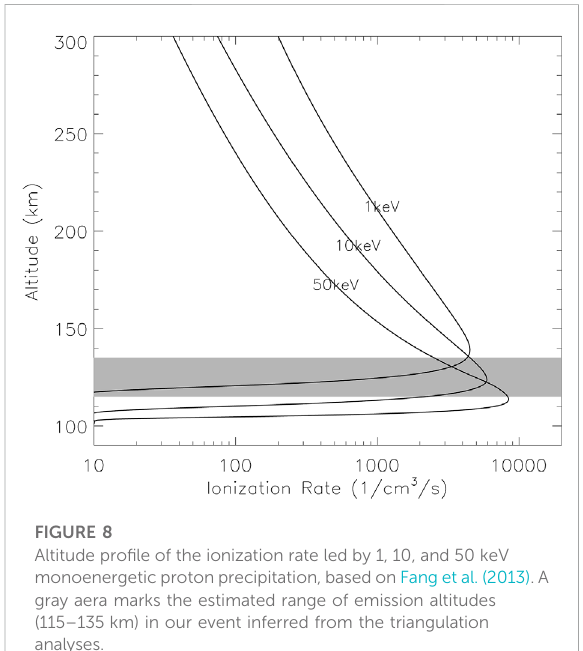
FIGURE 8 Altitude pro fi le of the ionization rate led by 1, 10, and 50 keV monoenergeticproton precipitation,based on Fang et al. (2013). A gray aera marks the estimated range of emission altitudes (115 – 135 km) in our event inferred from the triangulation